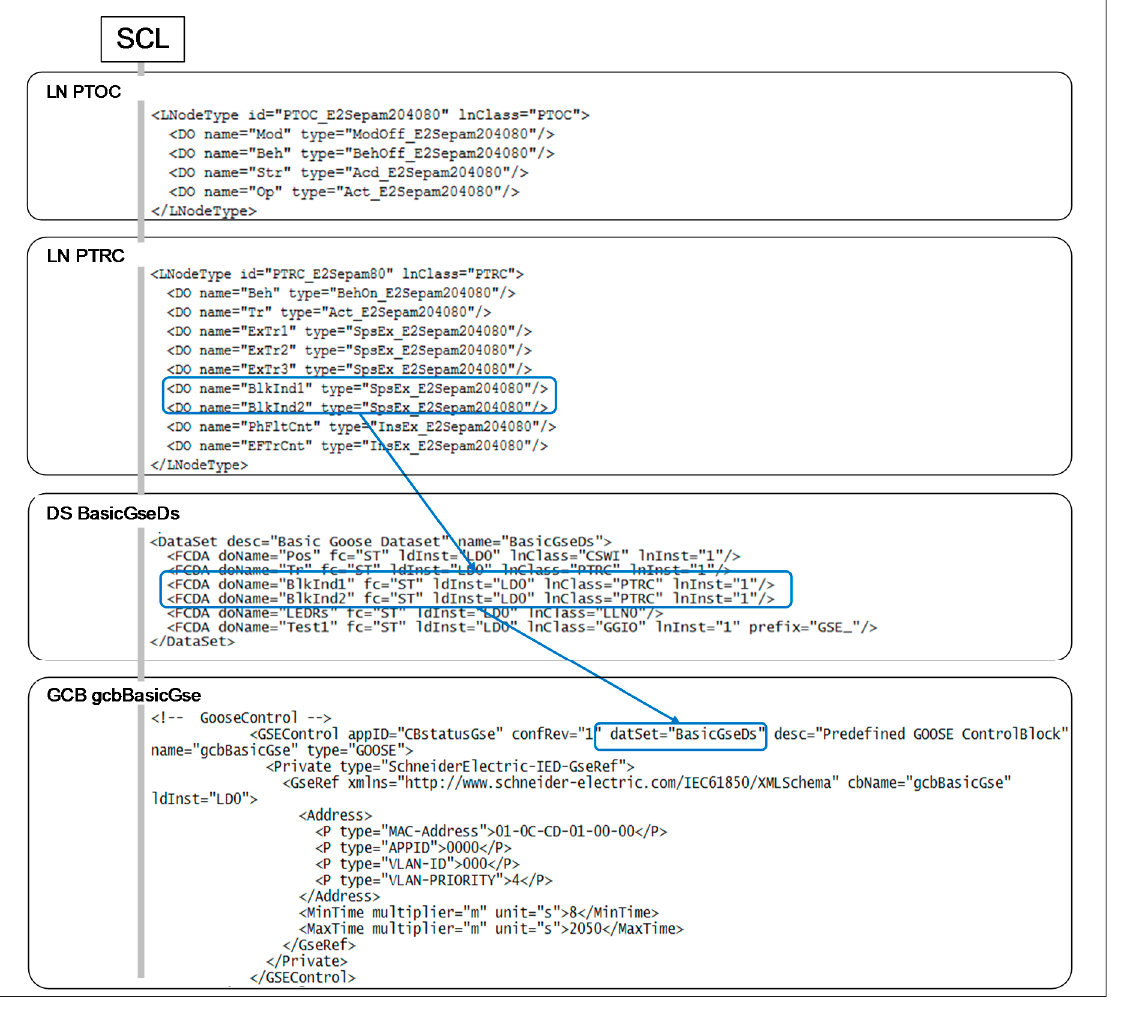
Figure 10. Sepam S82 implementation data model.